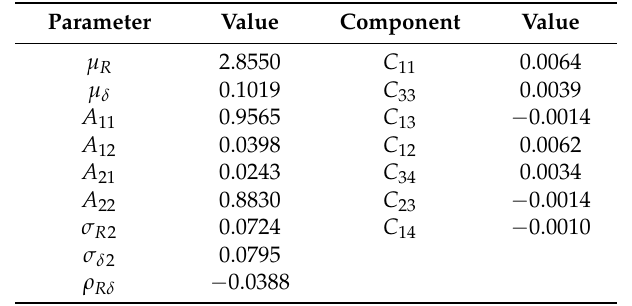
Table 1. Parameters of the synthetic rainfall generator calibrated. Vector µ , matrix A , and variance-covariance matrix C for definition of σ R 2 , σ δ 2 and ρ R δ (Adapted from [35]). The presented values are case study specific.